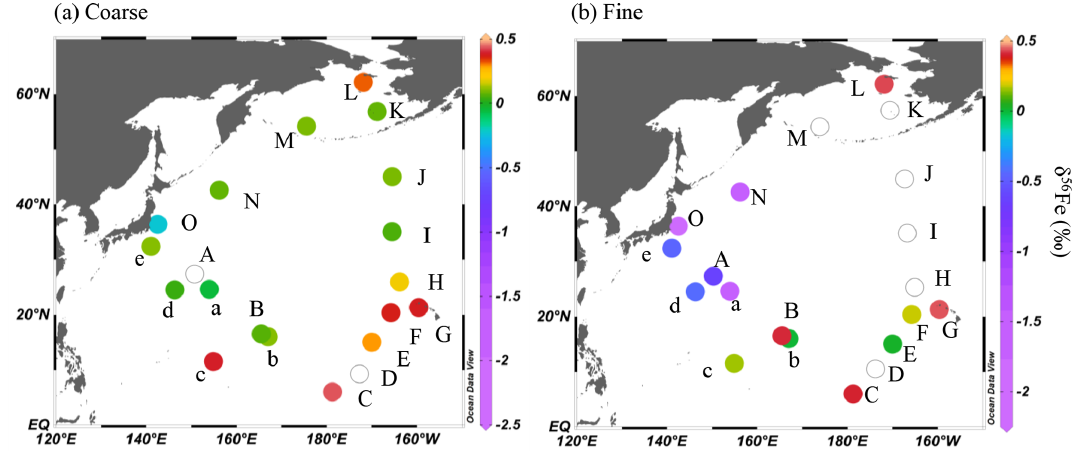
Figure 6. Iron isotope ratios of KH-13-7 and KH-14-3 samples in (a) coarse and (b) fine particles. Data in the clear circles were not available. Values are also shown in Tables S5 and S6. The figures were produced using Ocean Data View (Schlitzer,